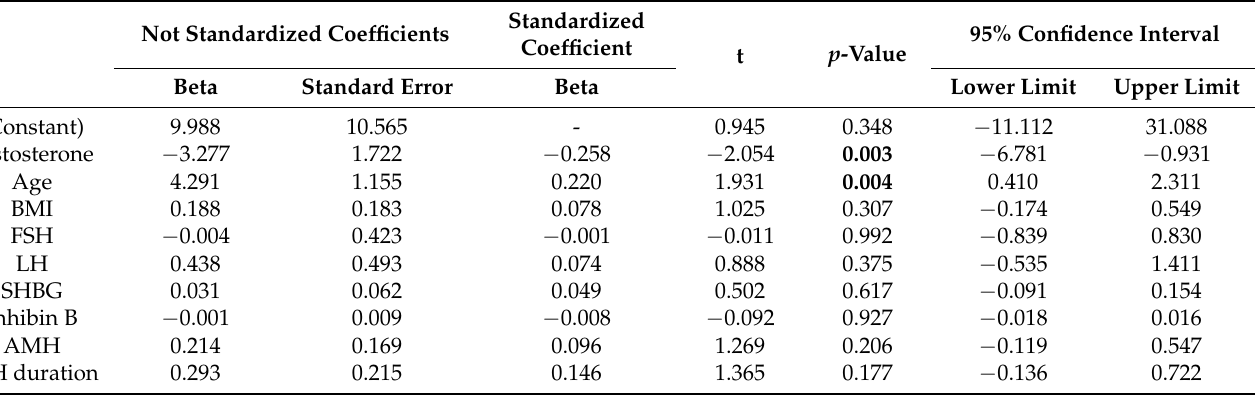
Table 3. Multivariate stepwise linear regression analyses using sperm DNA fragmentation index after three months of follicle stimulating hormone (FSH) treatment as dependent variable. Bold characters reported statistically significant parameters.